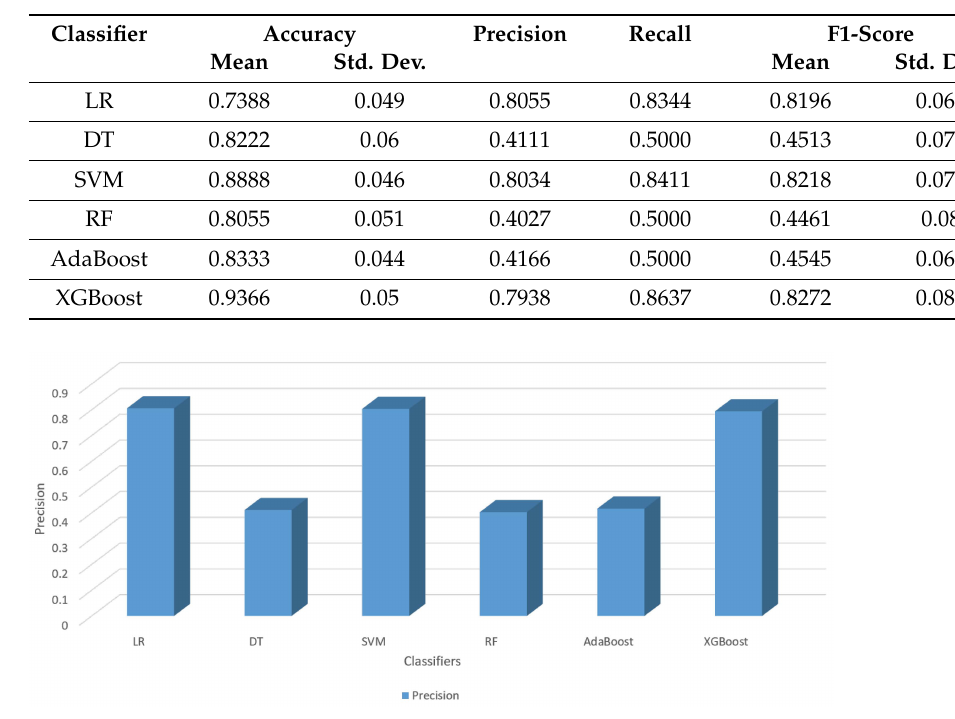
Table 3. Prediction results of classifiers after SMOTE.